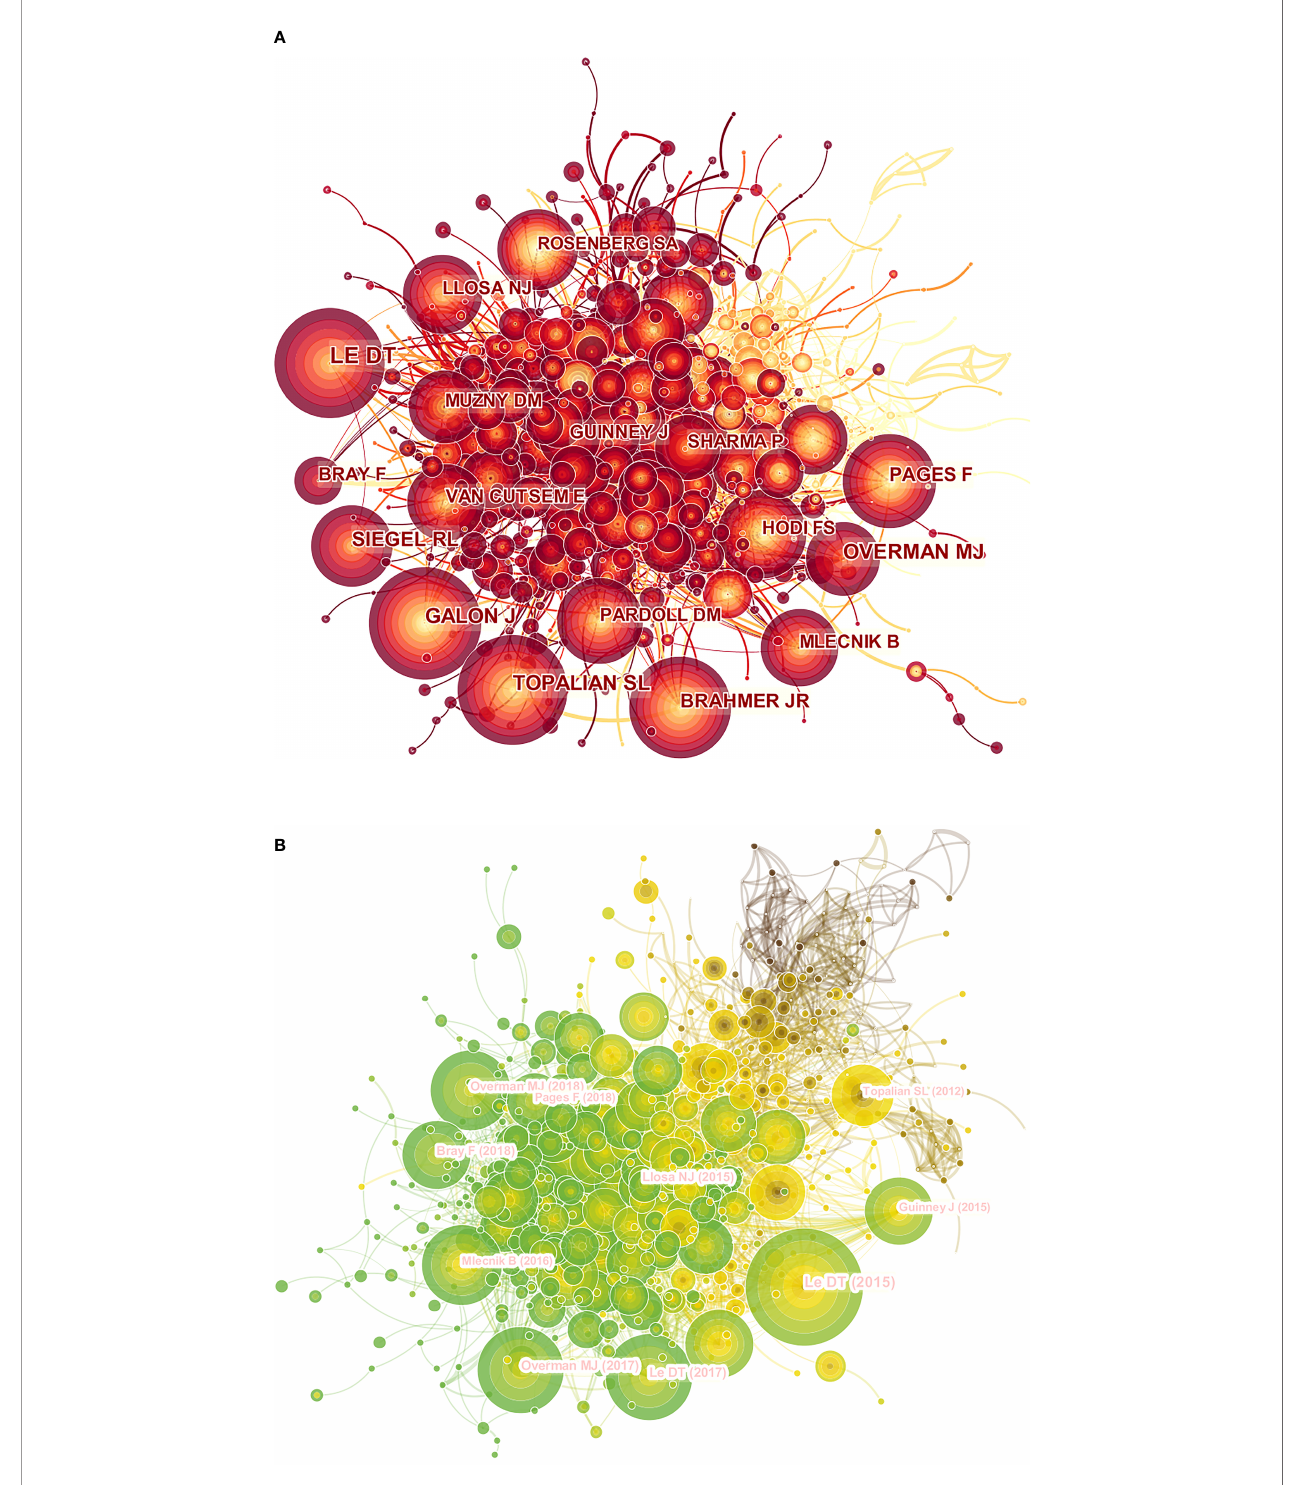
FIGURE 5 | A CiteSpace network visualization of co-cited authors and references regarding colorectal cancer immunotherapy. (A) Network visualization diagram of the co-cited authors of the Publications. (B) Network visualization diagram of cited references. Co-cited authors or cited references are indicated by the node. The co-citation relationship is indicated by the line connecting the nodes. The node area grows as the number of co-citations increases. The colors represent different years, in A, the color changes from yellow to red from 2012 to 2021, and in B, the color changes from brown to green from 2012 to